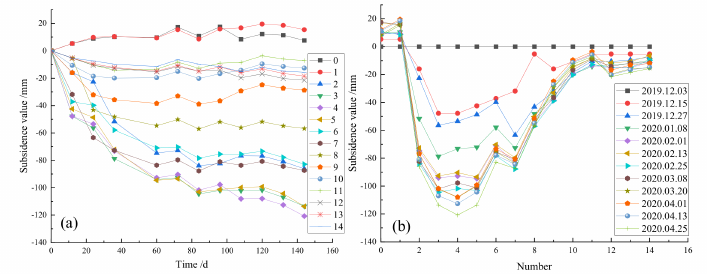
Figure 8. Subsidence of the inclination points: ( a ) Subsidence of the points with time. ( b ) Cumulative subsidence at each